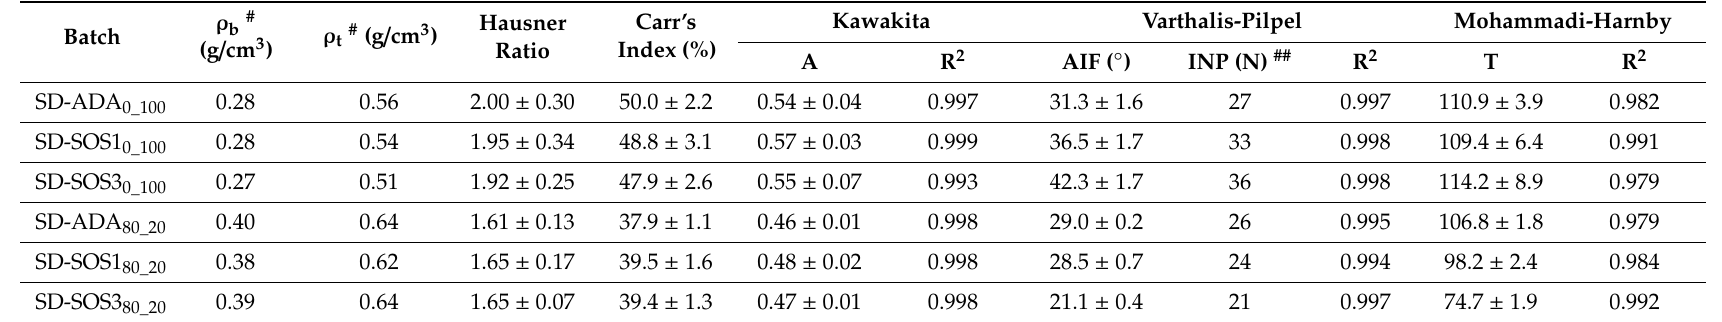
Table 4. Densities and packing properties of the experimental spray-dried PSC and PLM / PSC